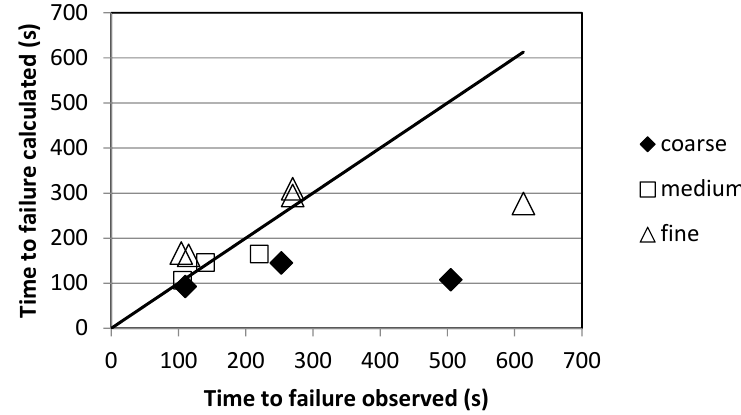
Figure 7. Observed and calculated time of failure of bed material during the flume tests.